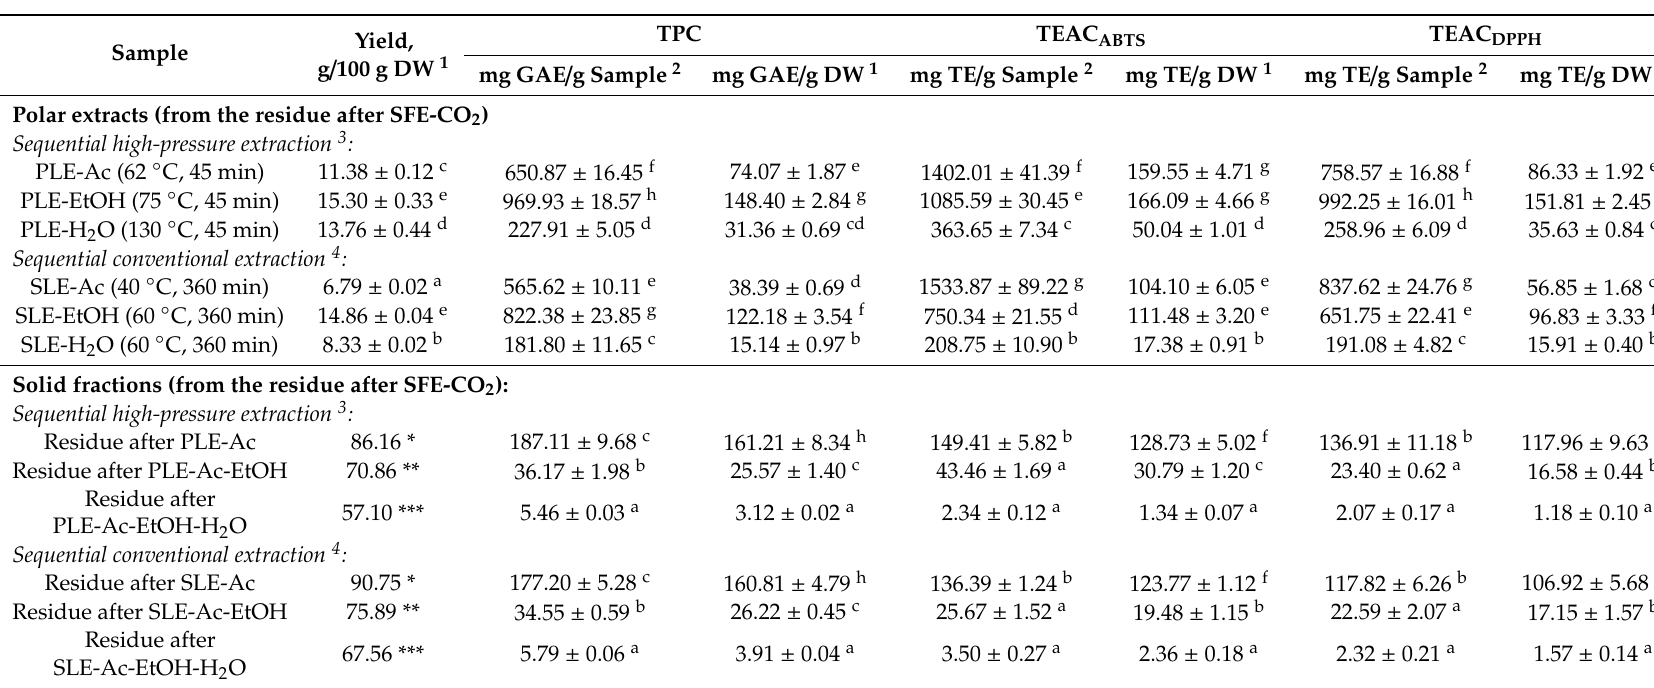
Table 4. Yields (g / 100 g), total phenolic content (TPC, mg GAE / g), ABTS • + , and DPPH • scavenging capacity (TEAC, mg TE / g) of D. fruticosa leaves polar extracts and solid residues after sequential pressurized liquid extraction (PLE) and solid–liquid extraction (SLE) with acetone, ethanol, and